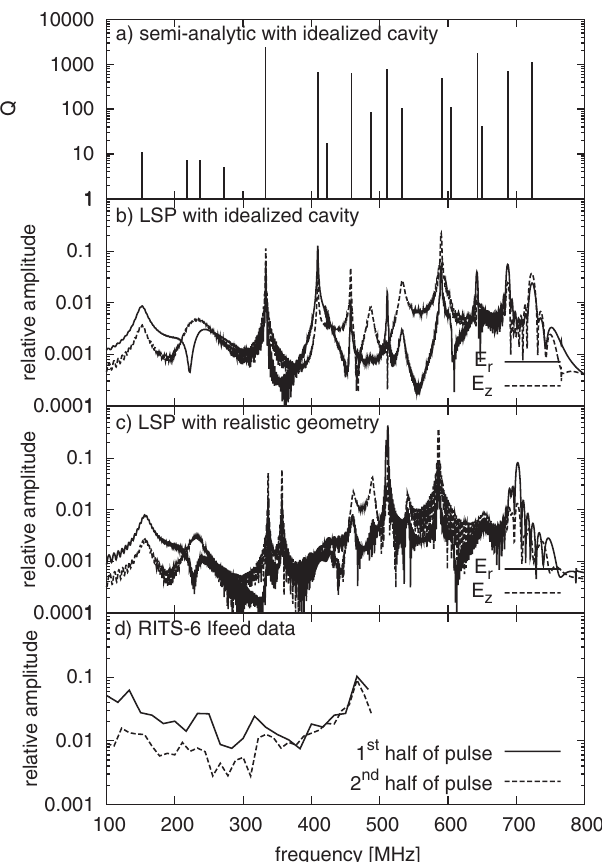
FIG. 13. (a) Cavity modes and Q values for the dustbin of Fig. 2 with an idealized, cylindrical knob from semianalytical calculations. (b) L SP -calculated field resonances for the same idealized cavity. (c) L SP -calculated field resonances for the exact geometry of Fig. 2. (d) Fourier transform of the measured RITS- 6 current from shot 57 for two time windows in the pulse, showing the decay of the modes below 300 MHz. The measure- ments are restricted to frequencies below 500